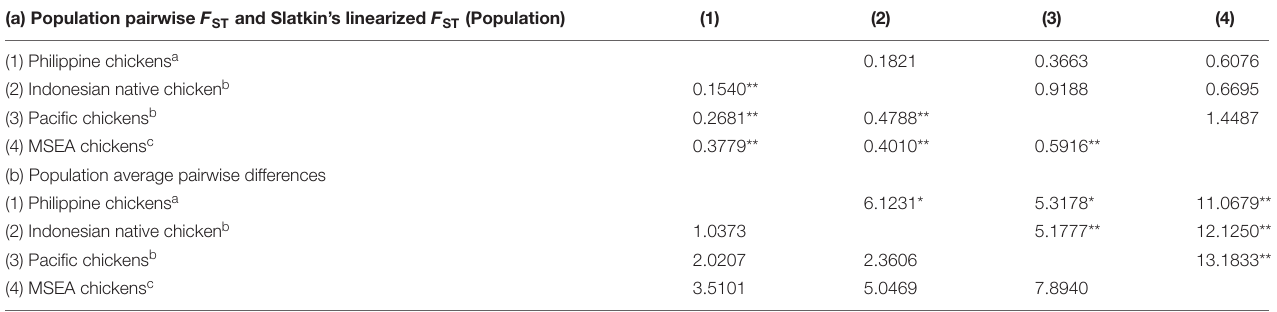
TABLE 2 | Genetic divergence between populations of Philippine chickens (RJFs and NCs), Indonesian, Pacific, and mainland Southeast Asia (MSEA) chickens at complete mtDNA D-loop sequences.